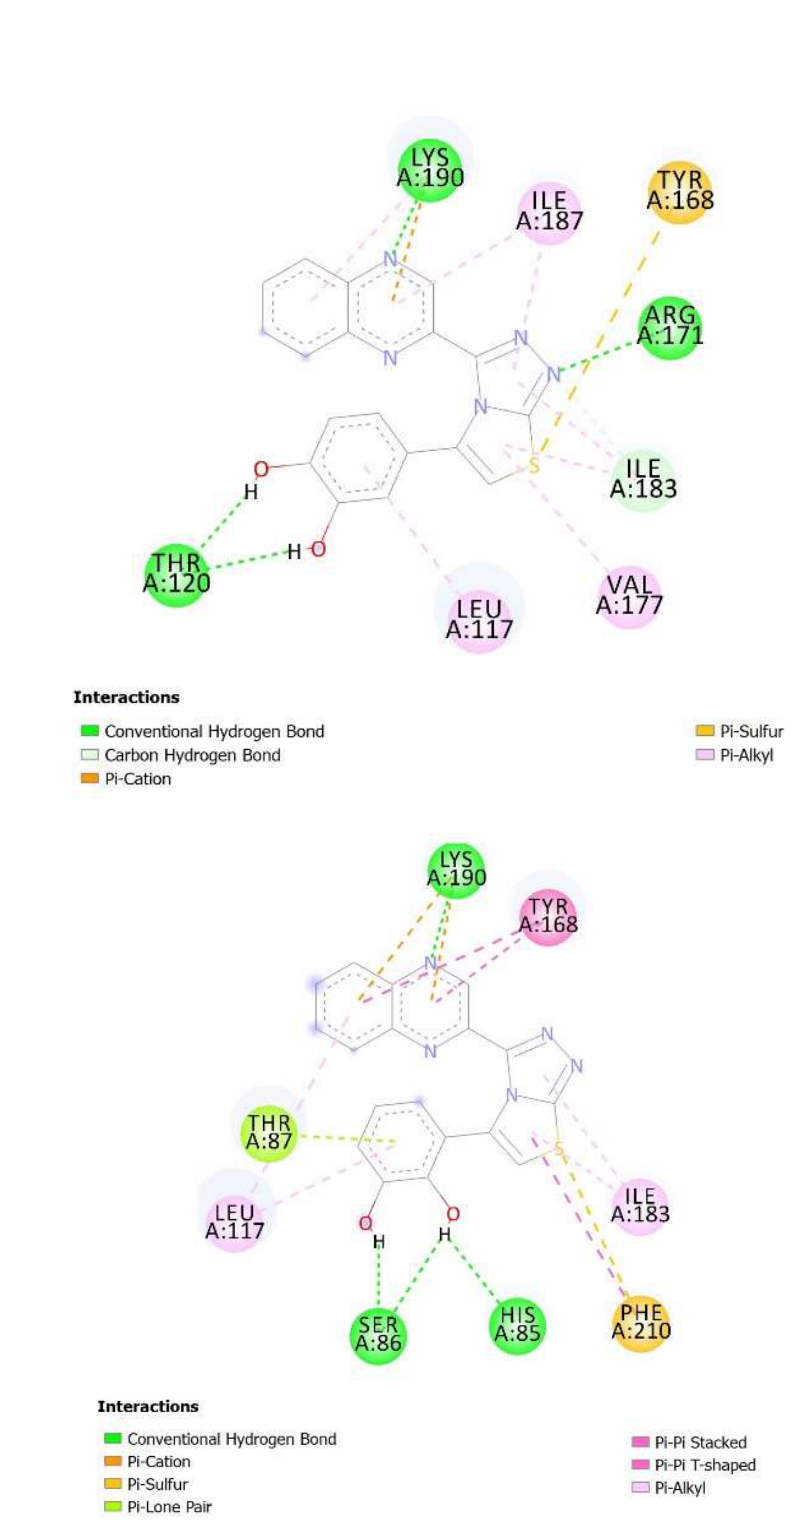
Figure 5. 2D closest interactions between active site residues of thymidine phosphorylase and synthesized compounds 14 , 16 , and 25 .